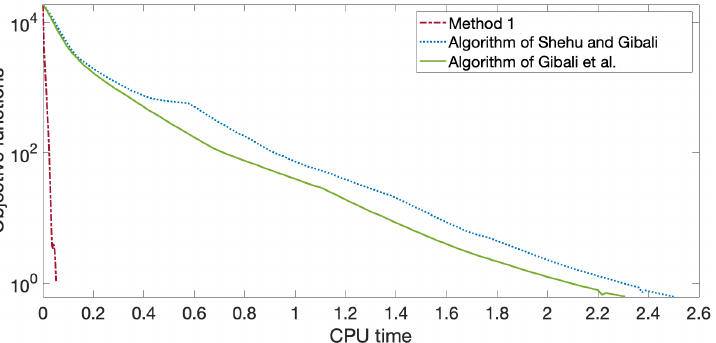
Figure 4. Graph of the objective function values and CPU time for P = 2048, K = 1024, m = 30 when MSE < 10 − 5